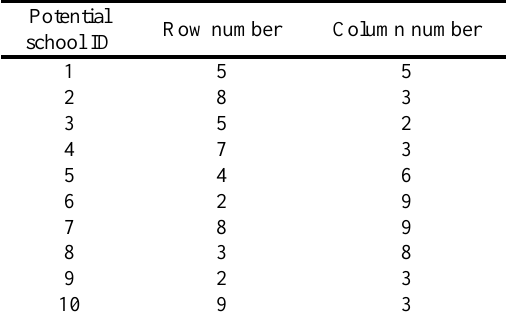
Table 2. The location of potential places for constructing new